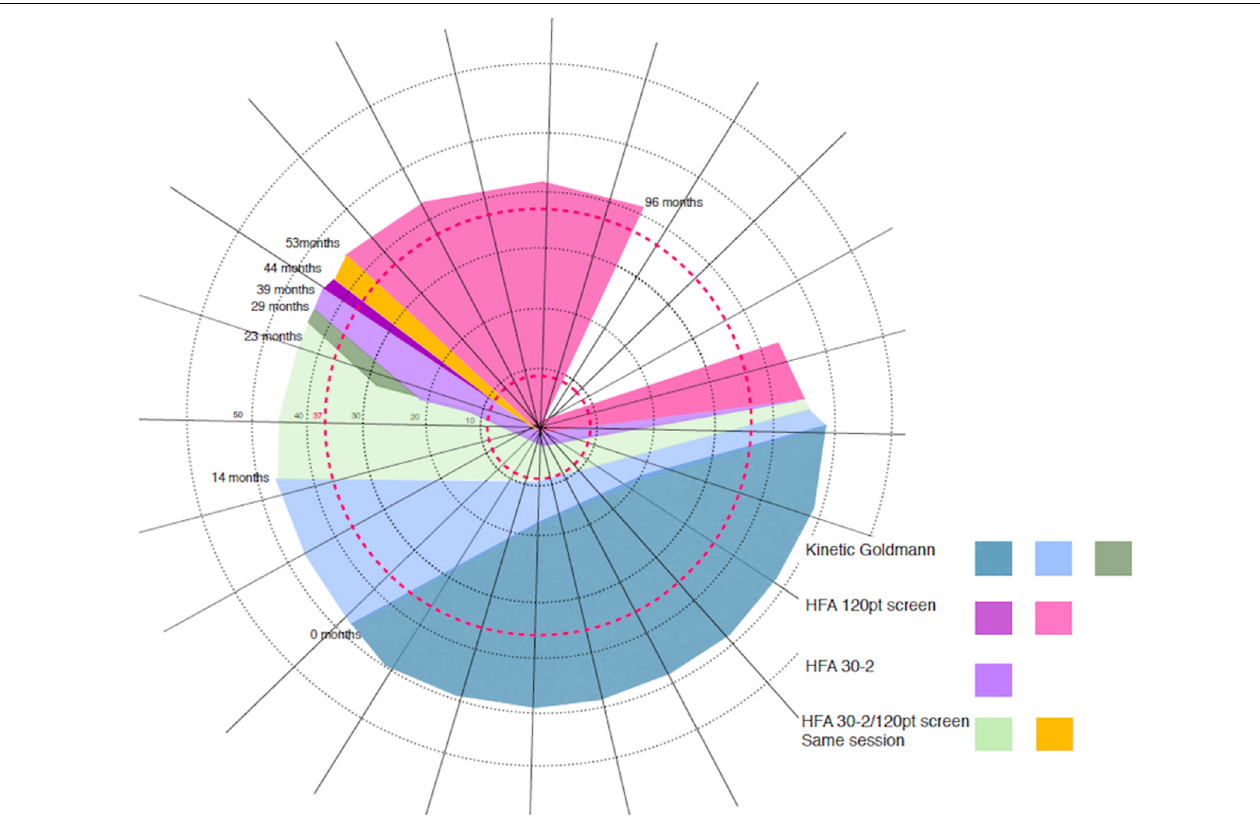
FIGURE 1 | Schematic representation of CW’s progressive visual field loss based on multiple visual field tests ∗ . Over the 8 years period CW showed a constant clockwise progression of visual field loss. Colored areas represent the loss as assessed at the time (in months) of eight visits. At the time of the first visit (0 months) the loss only affected part of the lower visual field (gray color). At the time of the last assessment (96 months after the first visit), the loss progressed to cover most of the visual field, with her vision remaining intact only within a wedge-shaped region in the upper right visual quadrant (blank region in the top right of the figure). Concentric rings around the center of the figure (corresponding to fixation) represent the maximum eccentricity of our two retinotopic mapping experiments (37.5 and 9 ◦